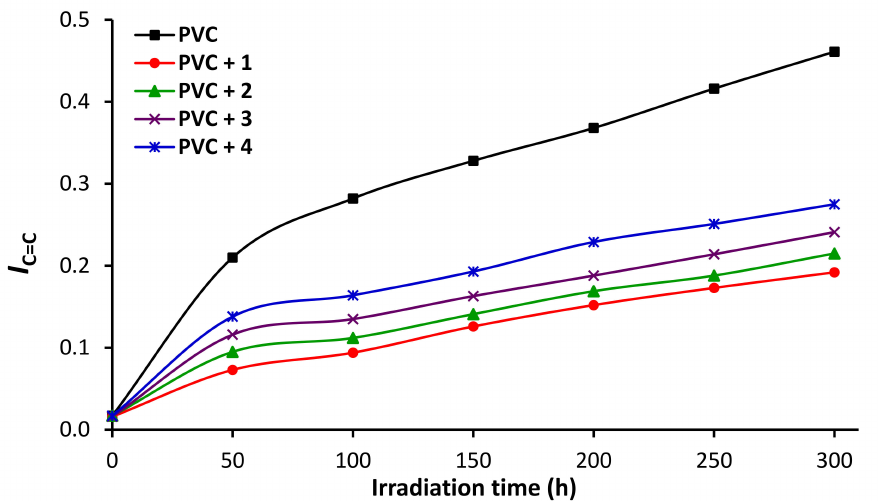
Figure 3. The I C=C index as a function of time during the irradiation of pure and tin-complex blended